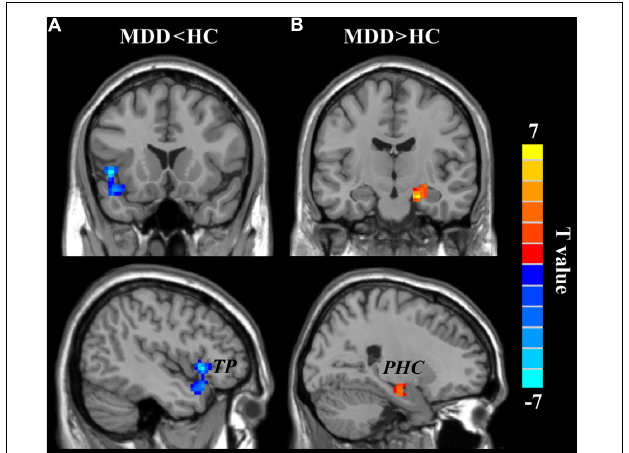
FIGURE 2 | The changed weighted global brain connectivity (wGCB) in major depressive disorder (MDD) patients. Two-sample t -test was used to compare the wGCB maps between healthy controls (HC) and MDD patients and identified (A) decreased wGCB in left temporal pole (TP) and (B) increased wGCB in right parahippocampus (PHC). The significance was determined using a cluster-level Monte Carlo simulation (5000 times) corrected threshold of p < 0.05 (cluster-forming threshold at voxel-level p <